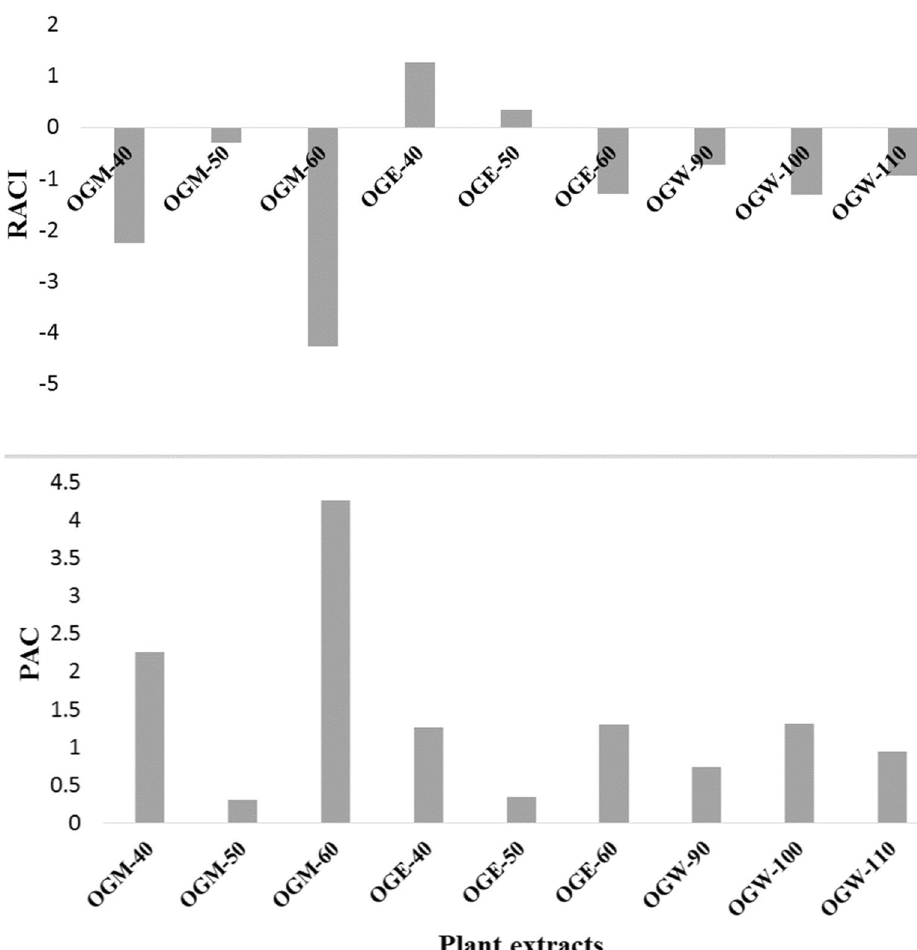
Figure 2. Phenolic antioxidant coefficient (PAC) and relative antioxidant capacity index (RACI) of O. gratissimum